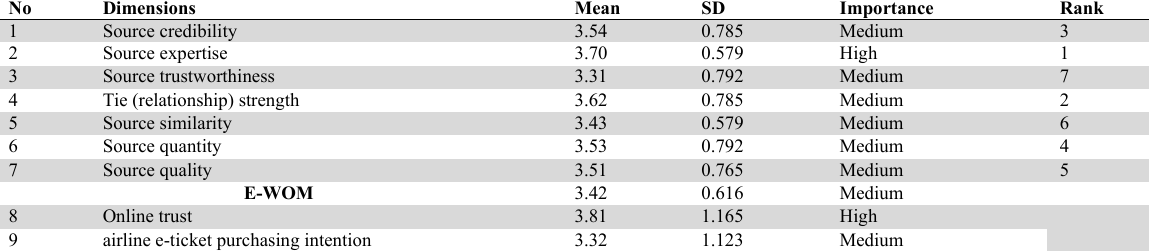
Means and standard deviations of E-WOM dimensions